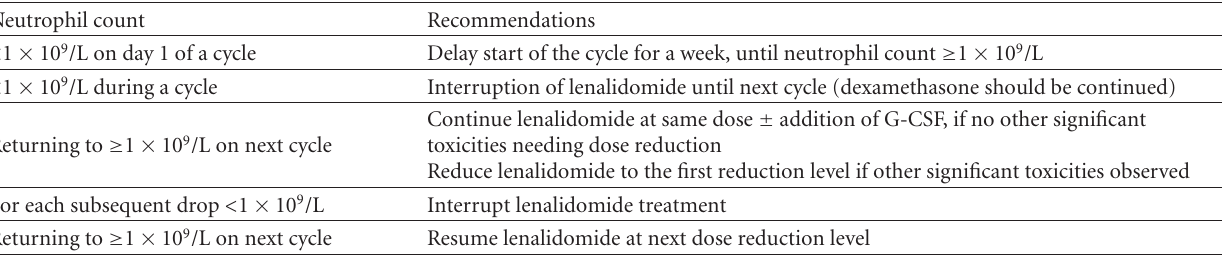
Table 3: Lenalidomide dose adjustment for neutropenia.